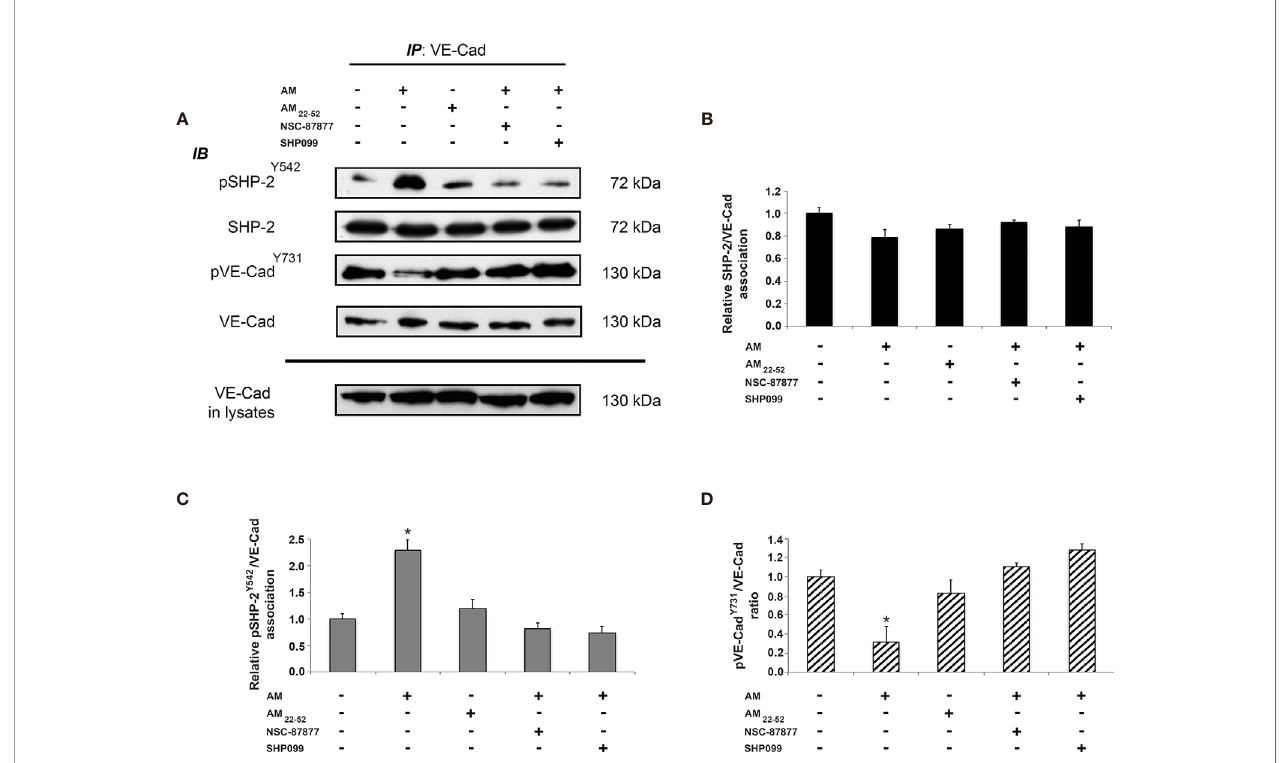
FIGURE 4 | AM induces phosphorylation for SHP-2 Y542 associated to VE-cadherin in HUVECs in vitro . (A) AM promotes phosphorylation for SHP-2 Y542 associated with VE-cadherin in vitro . HUVECs were treated for 16 h with AM (10 -9 M) in the presence or absence of SHP-2 inhibitors, or AM 22-52 (10 -6 M), and protein extracts were submitted to immunoprecipitation for VE-cadherin, followed by immunoblotting for pSHP-2 Y542 , SHP-2, pVE-cadherin Y731 , and VE-cadherin as indicated on the left. (B) Nearly equal amounts of SHP-2 are associated with VE-cadherin independently of treatment. (C) Signi fi cant increases and decreases for pSHP-2 Y542 pulled down with VE-cadherin, subsequently to AM in presence or absence of SHP-2 inhibitors and AM 22-52 treatment. (D) Signi fi cant decrease for pVE-cadherin Y731 subsequently to AM, which is lost upon treatment with SHP-2 inhibitors. No changes can be observed with AM 22-52 when compared to control. * p < 0.05. Each experiment is representative of three (B – D) independent experiments. Results are shown as means ±